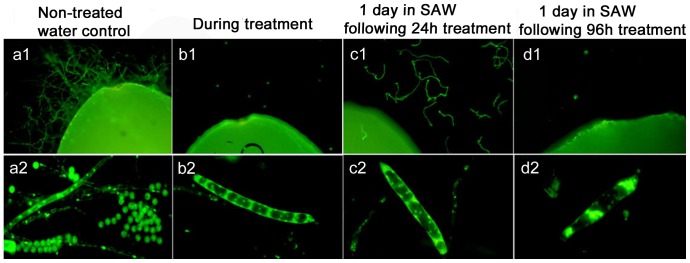
Viability of treated Saprolegnia spores and zoosporangia during treatment and post-treatment removal.Fluorescence microscopy showing the viability of boric acid treated Saprolegnia spores and zoosporangia with SYTO 9 stain. a1) Colonization is seen on control seed. a2) Normal zoosporangium sporulating. b1) Non-colonized seed during treatment. b2) Effect on zoosporangium during treatment. c1 and c2) Spores and zoosporangium were treated for 24 h with BA and left in sterilized aquarium water (SAW) for another 24 h after treatment was terminated. Germlings can be seen surrounding the seeds in c1. c2) shows a close-up of zoosporangium treated as in c1. d1 and d2) Spores and zoosporangium were treated for 96 h in BA and then left in SAW for 24 h after treatment was terminated. There is no colonization on seeds after 96 h BA treatment (d1) and the zoosporangium (d2) appears with condensed staining and a thin wall.